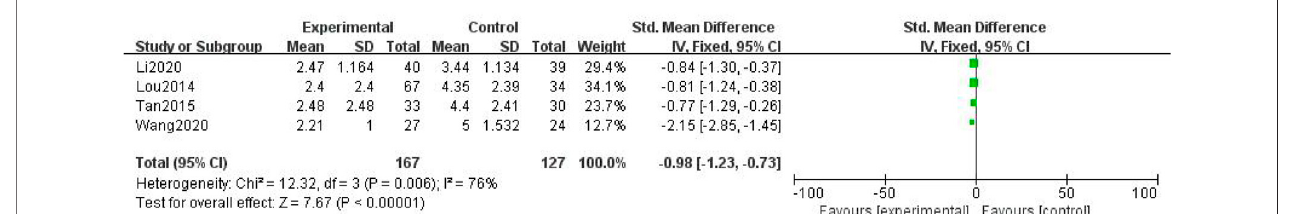
FIGURE 11 | Numerical rating scale.